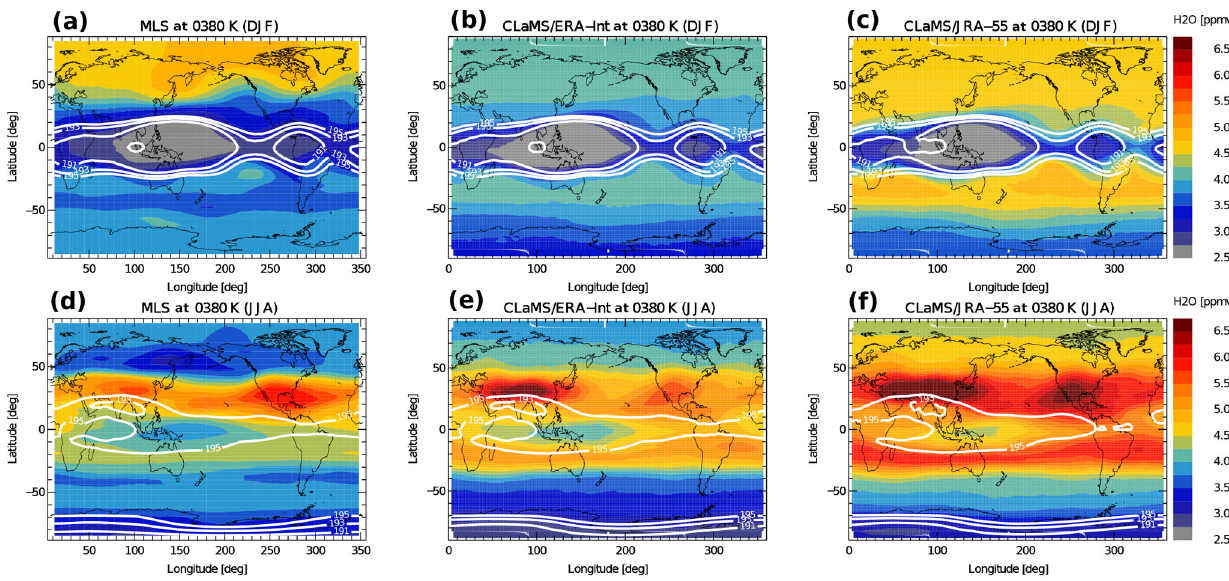
Figure 5. Water vapour maps at the potential temperature level of 380K from MLS (a, d) , and CLaMS simulations driven by ERA-Interim (b, e) and JRA-55 (c, f) . Shown are winter (December–February, DJF) and summer (June–August, JJA) data, respectively, from a 2004–2013 climatology. White lines show temperature contours (191, 193, 195K). Note that the temperatures in (a, d) are from ERA-Interim sampled at the MLS locations, those in (b, e) are from ERA-Interim and those in (c, f) are from